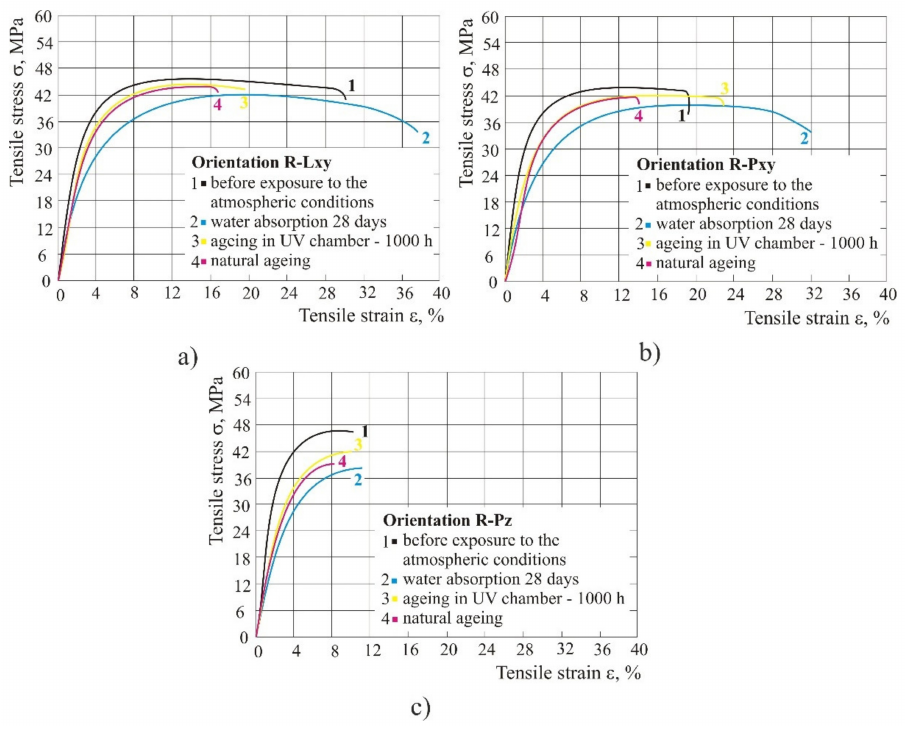
Figure 9. Impact of different weathering conditions on recycled material: ( a ) orientation Lxy, ( b ) orientation Pxy, ( c ) orientation Pz.